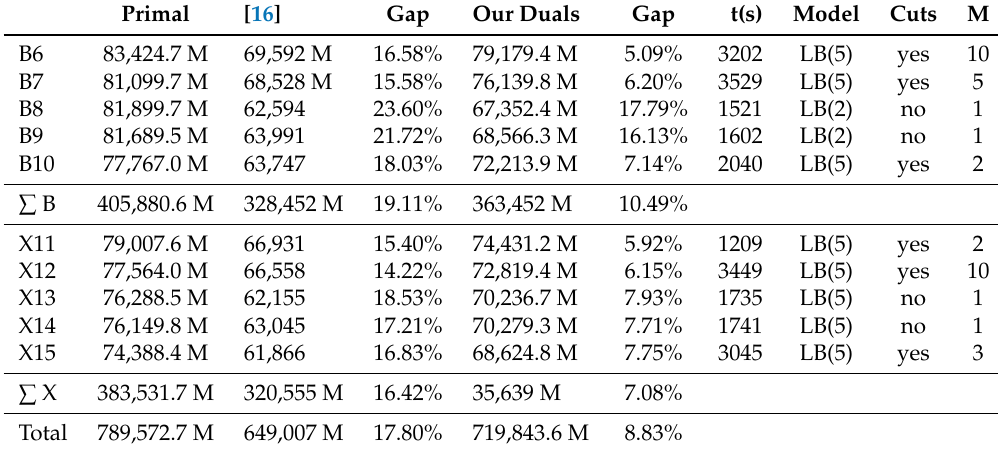
Table 9. Comparison of our best dual bounds for datasets B and X allowing at most 1 h total computation to the ones from [16].